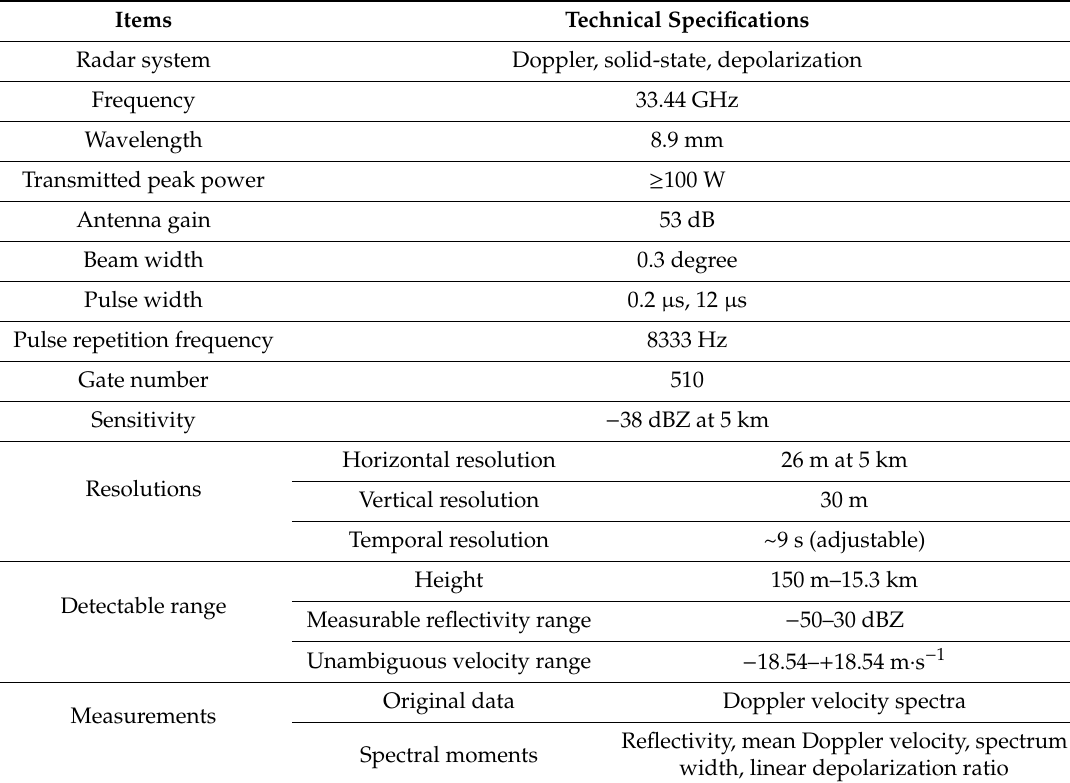
Table 1. The Ka-band millimeter wave cloud radar (MMCR) key technical